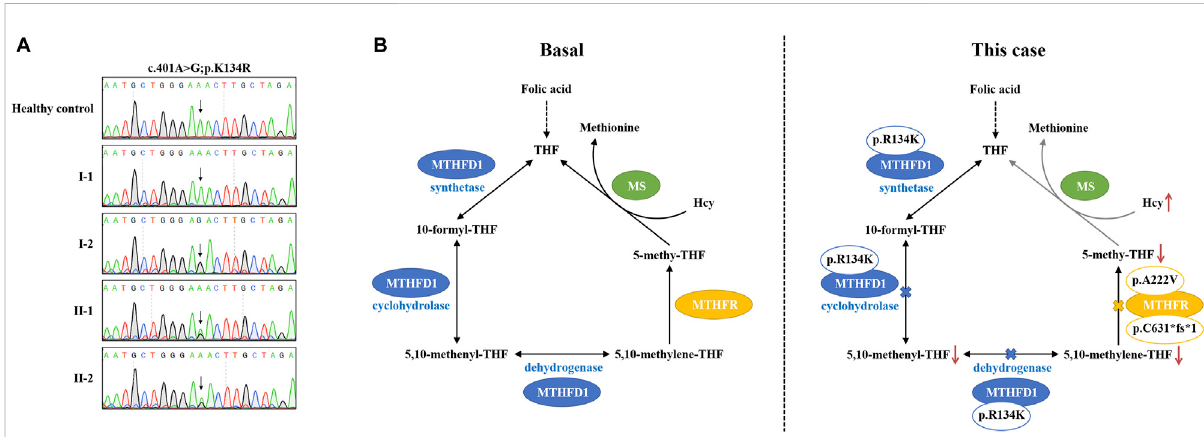
FIGURE 3 Pathogenesis hypothesis of the proband. (A) Sequencing data on MTHFD1 variants in this family. (B) Both MTHFD1 and MTHFR participated in the cytoplasmic folate cycle. Three reactions are catalyzed by MTHFD1 : the conversion of formate and THF to 10-formyl-THF (synthetase); the interconversion of 10-formyl-THF and 5,10-methenyl-THF (cyclohydrolase); and the reduction of 5,10-methenyl-THF to 5,10-methylene-THF (dehydrogenase). MTHFR catalyzesthereductionof5,10-methylene-THFto 5,10-methenyl-THF.5,10-Methenyl-THFisutilizedbymethionine synthase to convert homocysteine to methionine. In our case, the p. R134K variant is located within the dehydrogenase/cyclohydrolase domain of the MTHFD1 protein which may lead to reduction of 5,10-methenyl-THF and 5,10-methylene-THF syntheses. On the other hand, the compound heterozygous variants, p. A222V and p. C631*fs*1, may result in dysfunction of the MTHFR enzyme, causing reduction of the 5,10-methenyl-THF synthesis.Asaresult,theconversionofhomocysteinetomethionineisinhibitedbythelowlevelof5,10-methenyl-THF,whichmaycontributetothe abnormal accumulation of plasma – Hcy and fi nally lead to HHcy and failure of folic acid therapy, as observed in our